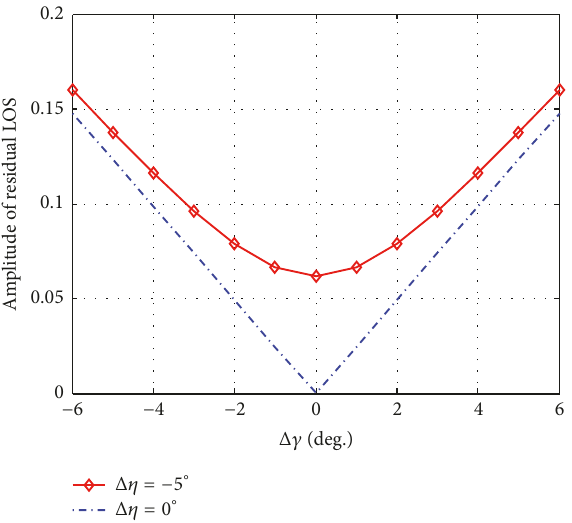
Figure 5: The magnitude of residual LOS